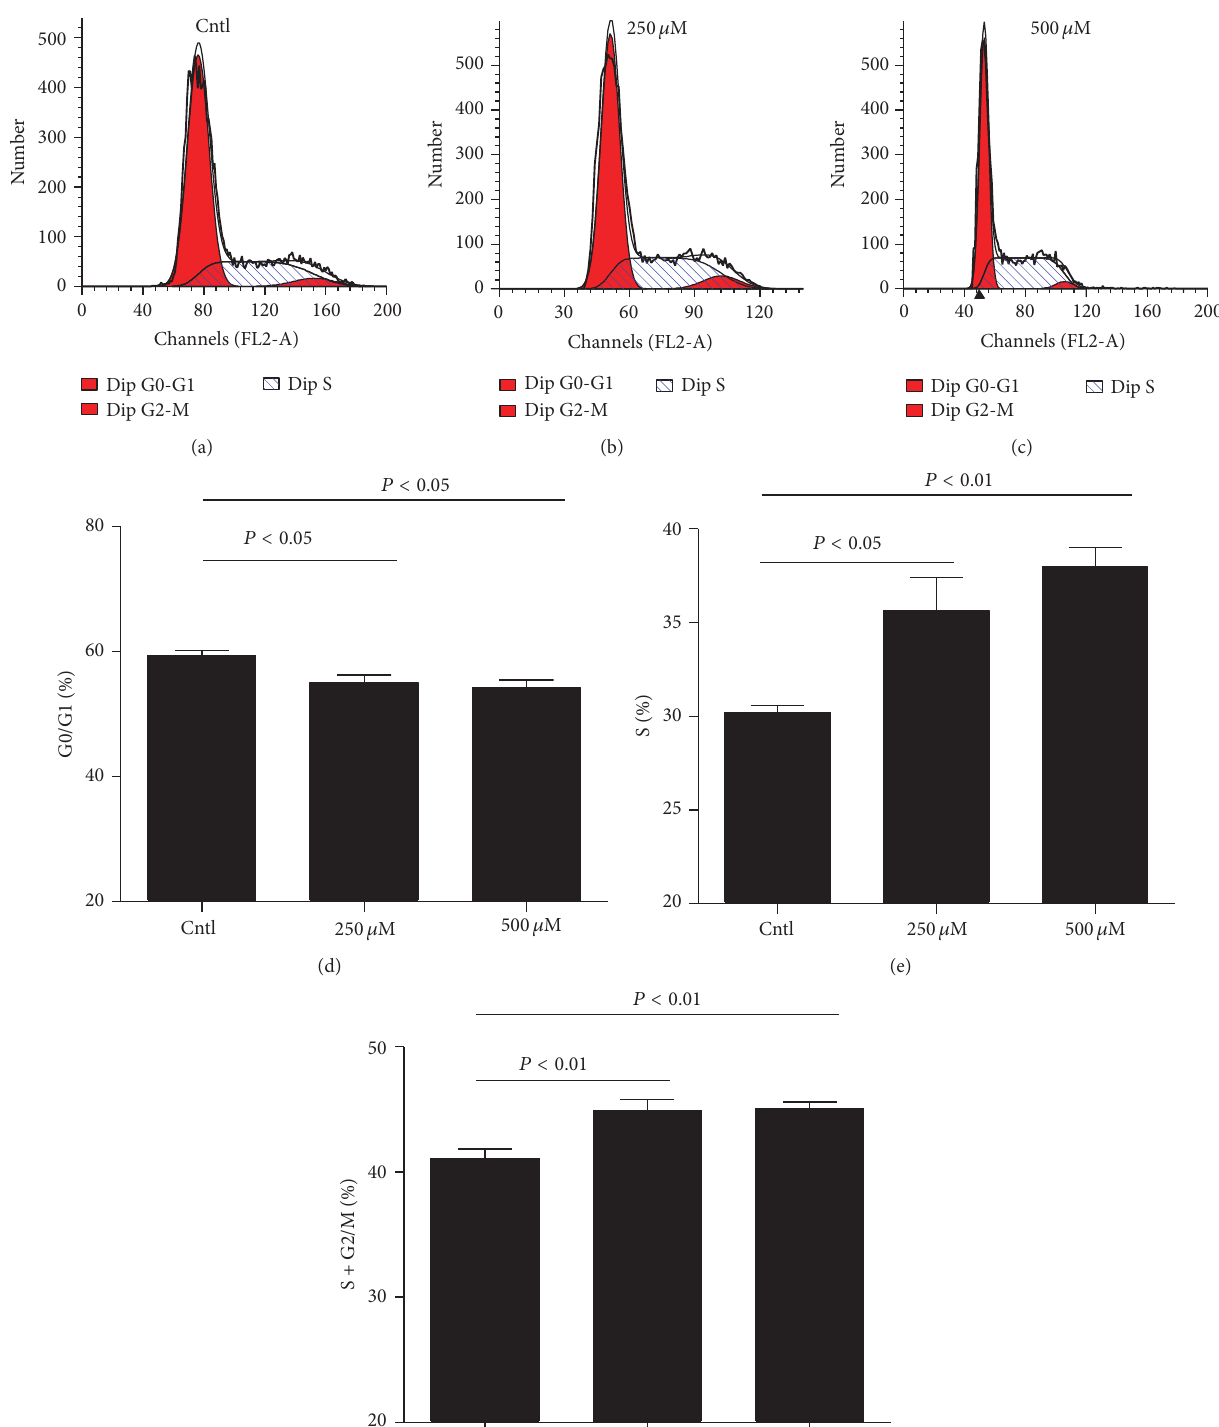
Figure2:EffectofISoncellcycleprogressioninMCs.Thepercentageofcellsatdifferentcellcyclephaseswasdetectedbyflowcytometryafter MCs were treated with the indicated doses of IS for 24h. (a–c) Representative images of cell cycle with different doses of IS. (d–f) Percentage of cells at S, G1/G0, and (S + G2)/M phases. Values are means ± SD; 𝑛 = 6 in each